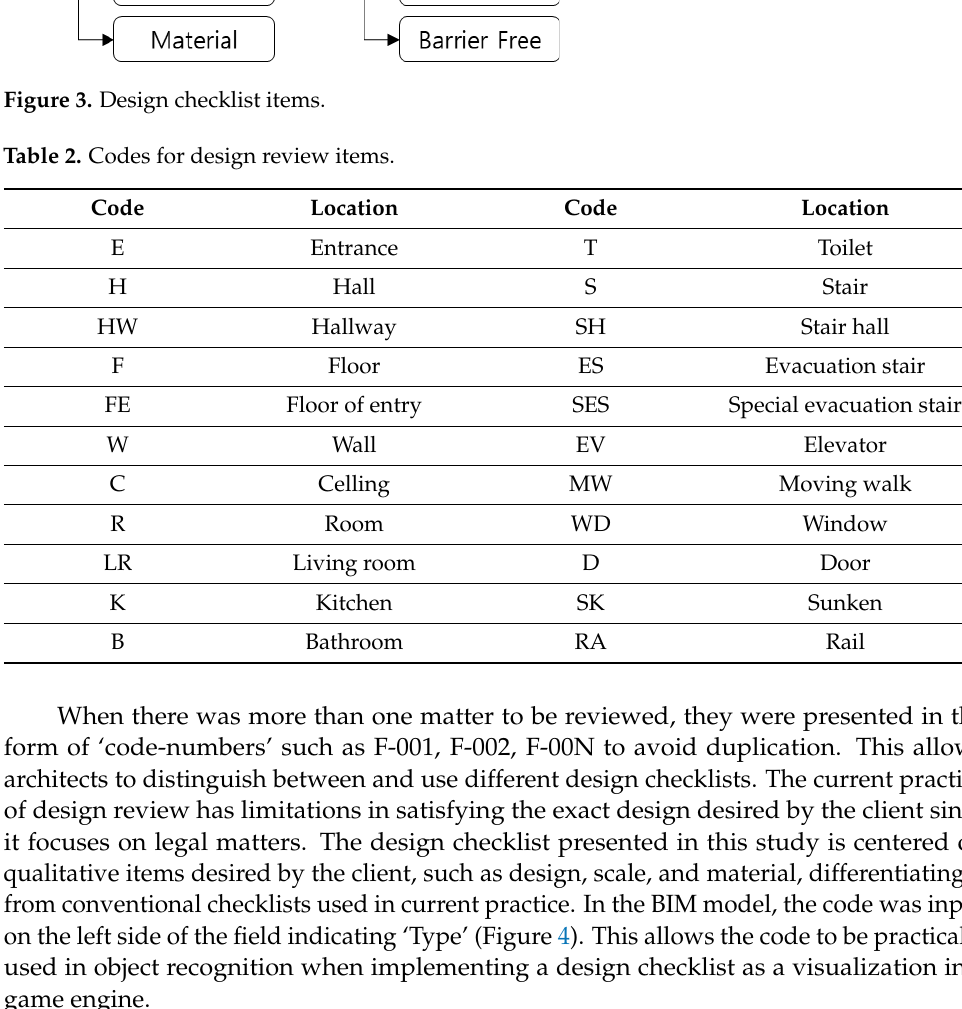
Figure 5. Process of AR-based design checklist connection. A game engine was used to combine the BIM model and the checklist in the AR- based environment, and a script was written in the commonly used Unity 3D Pro; func- tions were developed through customization. First, BIM-based 3D modeling was per- formed and only the architectural model was modeled. The model was exported to the game engine through use of a plug-in. The BIM model can be opened in the game engine, which runs in the cloud and the design review checklist is linked through a C#-based script [26]. 4.2. Algorithm Design and Implementation Figure 6 shows a plan for linkage with the AR-based design checklist. The visual direction in which the design checklist should appear in the spatial location where the avatar or person is in the AR environment is indicated in the drawing.